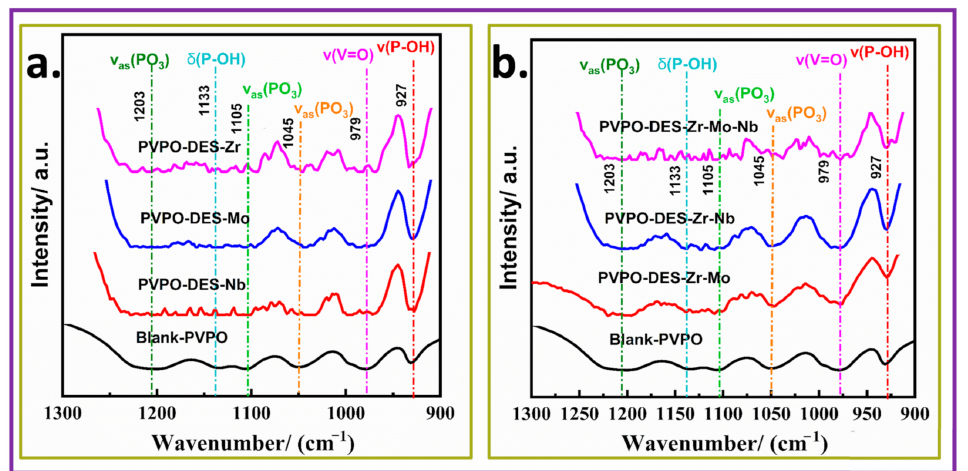
Figure 6. The FT-IR spectra of VPO precursor prepared from mono- ( a ), and bi- and tri-metallic ( b ) DES.